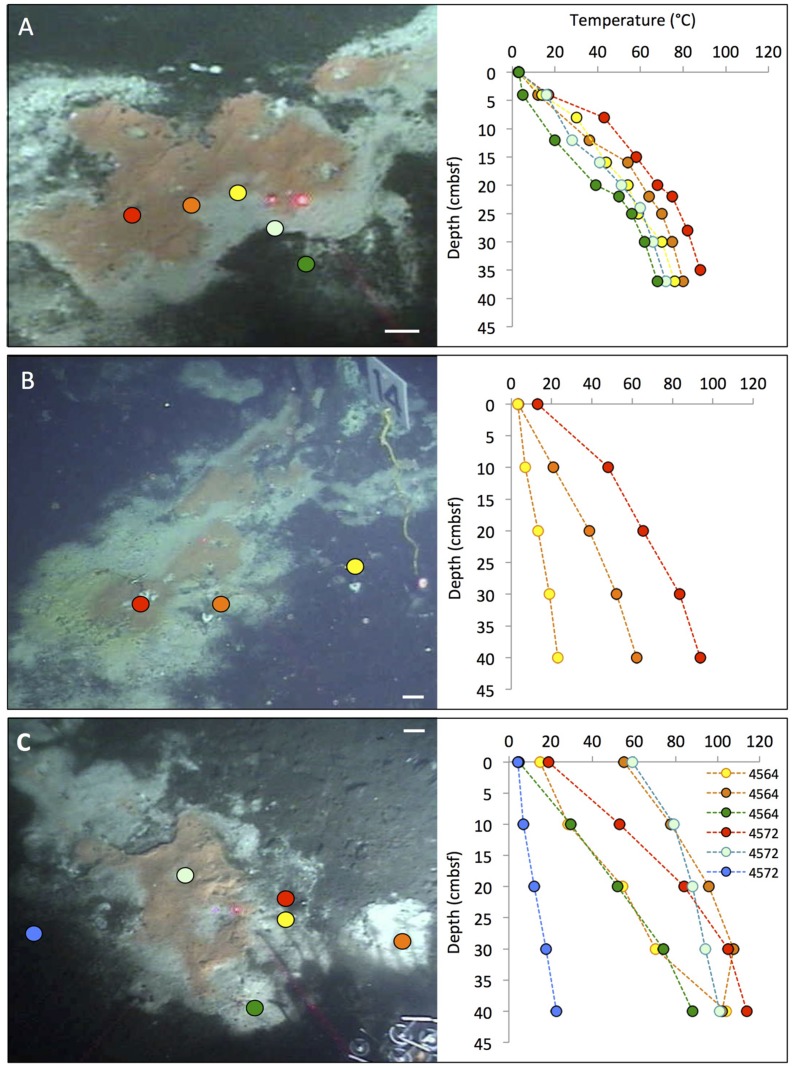
Typical “fried egg” microbial mats. The orange Beggiatoa mats in the center tend toward pink in these frame grabber images; yet direct in situ observation and shipboard recovery show orange as the actual color. In situ temperature gradients in the color-marked positions are measured with Alvin’s heat flow probe. The scale bar corresponds to 10 cm. (A) The Marker 2 mat was the first Guaymas Basin mat, where a temperature gradient from the center of the mat to the surrounding bare sediment was measured, using the Alvin high-temperature probe. Alvin heading 255, depth 2000.5 m, GMT 17:37:07, dive 4483, December 6, 2008. (B) The mat at Marker 14 was equipped with one temperature logger each in the orange center, the white fringe, and nearby bare sediment. Alvin heading 208, depth 2007.8 m, GMT 16:38:23, dive 4562, November 23, 2009. Geochemistry and temperature profiles of this mat are published (McKay et al., 2012); the temperature profiles are replotted here for comparison. (C) The large mat at Marker 27 is shown here before installment of temperature loggers or sampling. Alvin heading 36, depth 2002.5 m, GMT 22:02:30, dive 4564, November 25, 2009. Photographs courtesy of the Woods Hole Oceanographic Institution, from RV Atlantis cruises AT15-40 and AT 15-56.